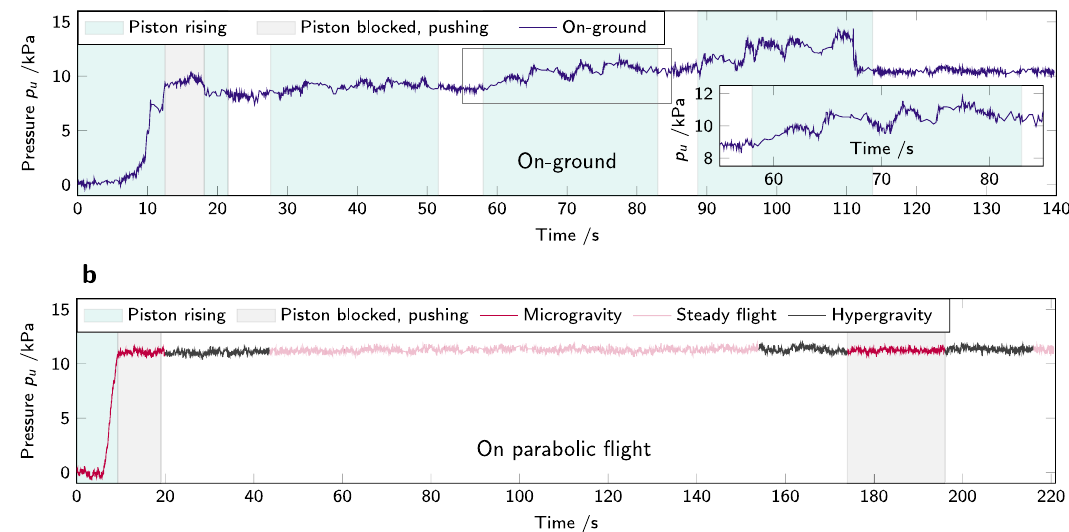
Fig. 5 Pressure evolution for a duration of ≈ 200 s after the initial densi fi cation step leading to jamming. Pressure is recorded by the top sensor inside the powder container. a on-ground (gnd) and b microgravity ( μ -g). The inset of a is a close-up of the pressure evolution during the second step-up of the piston, where the time and pressure range expanded in the inset are highlighted on the main panel by a gray rectangle. After an initial steep rise in pressure both on-ground and in microgravity, corresponding to jamming of the granular packing, on- ground the packing yields under the stress applied by the piston rise. On the contrary, the packing jammed in microgravity remains stable against hypergravity and against pressure applied by the piston in the next microgravity period.